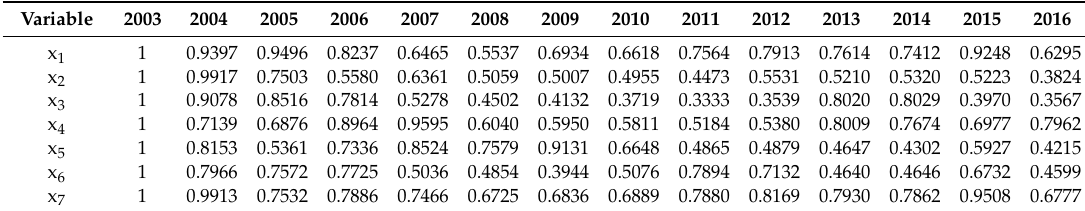
Table 7. Results of Grey correlation (2003–2016).